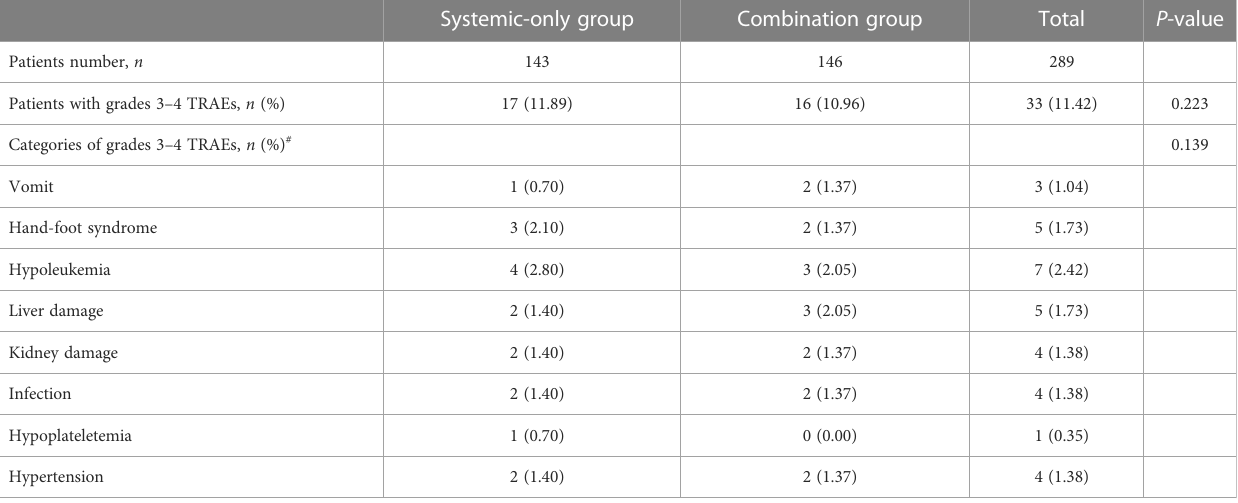
Systemic-only group Combination group Total P -value Patients number, n